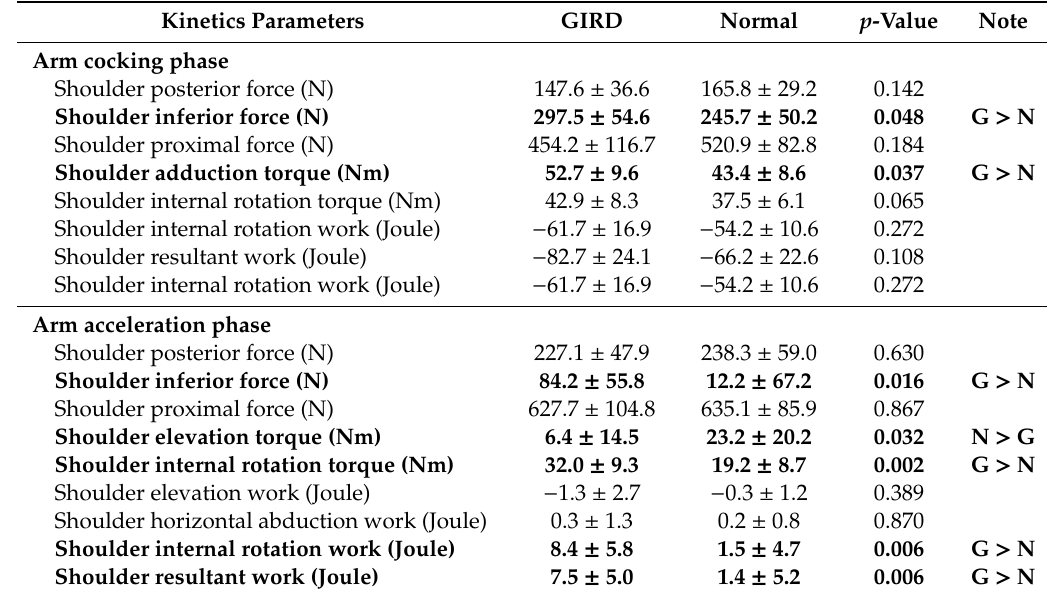
Table 3. Comparison of kinetic parameters in GIRD and Normal